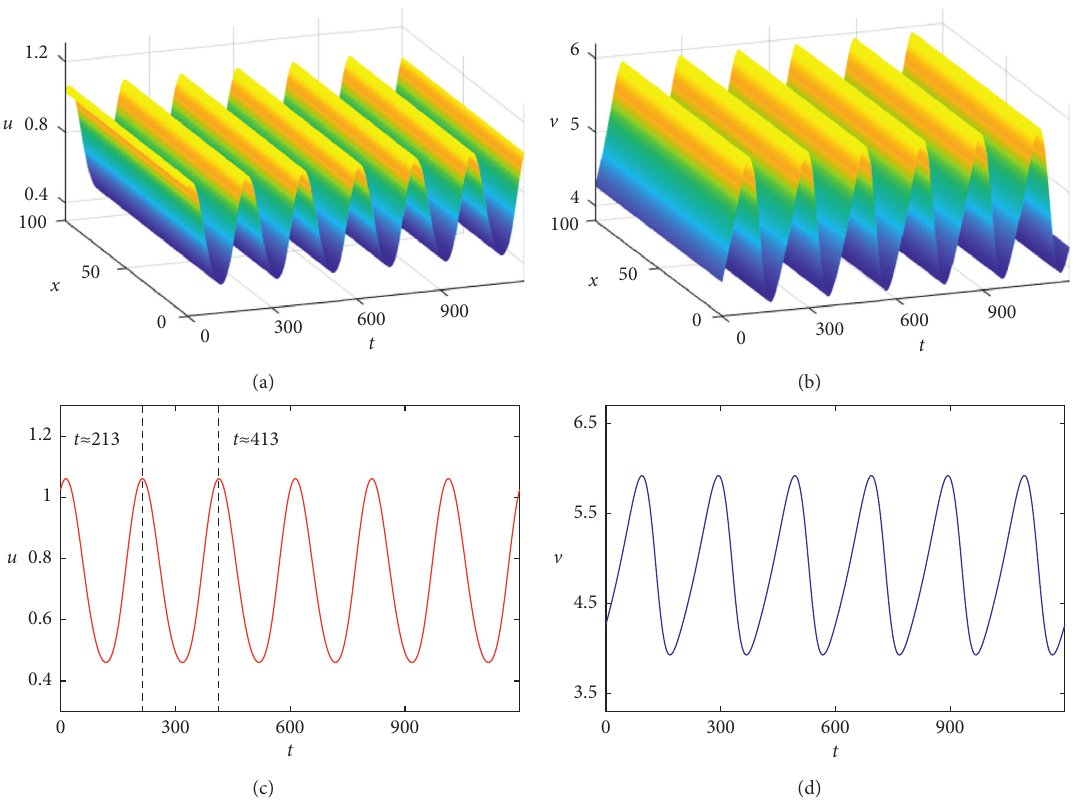
Figure 3: Numerical solutions of system (6a)–(6c): (a) prey population u , (b) predator population v , (c) profile of u ( t ) at x � 50, and (d) profile of v ( t ) at x � 50. Here, r ( t,x )� 1 . 2 + 0 . 1sin ( π ∗ t /100 ) , K ( t,x )� 2 + 0 . 5cos ( π ∗ t /100 ) , a ( t,x )� 0 . 8 + 0 . 005cos ( π ∗ t /100 ) , b ( t,x )� 0 . 9 + 0 . 005cos ( π ∗ t /100 ) , e ( t,x )� 0 . 7 − 0 . 005sin ( π ∗ t /100 ) , c ( t,x )� 0 . 02 + 0 . 01cos ( π ∗ t /100 ) , δ ( t,x )� 0 . 12 + 0 . 05cos ( π ∗ t /100 ) , μ � and μ 2